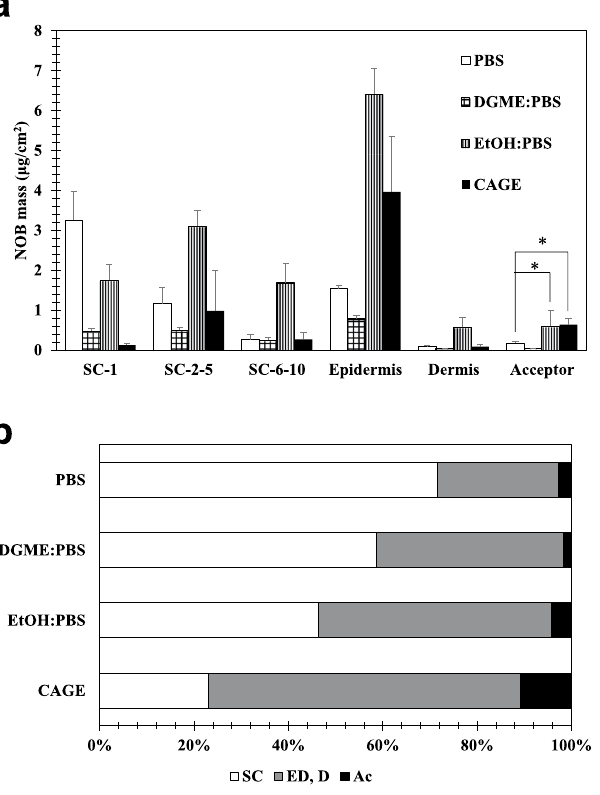
Figure 5. Evaluation of the transdermal absorption of NOB using chemical penetration enhancers. (a) Various solutions, 300 μ L of 1 mg/mL NOB in PBS, 50:50 ( v : v ) DGME: PBS, 50:50 ( v : v ) EtOH: PBS, and CAGE were added to the donor of a FDC and incubated for 24 h at 37 °C. After incubation, a tape stripping method was performed using ten tapes to get layers of the SC and the remaining epidermis, dermis, and acceptor were collected to determine the NOB concentration in each fraction. Each column represents the mean ±